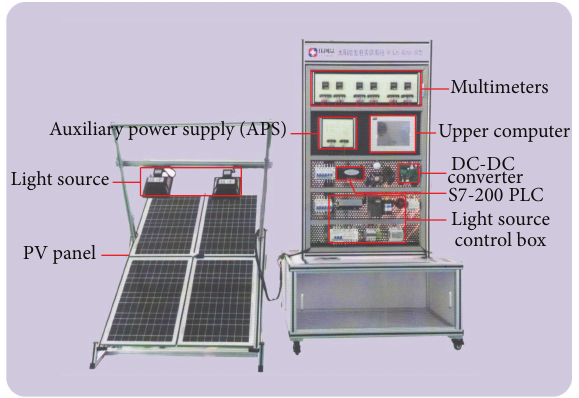
Figure 10: The experiment setup of the light source-driven photo- voltaic MPPT system.